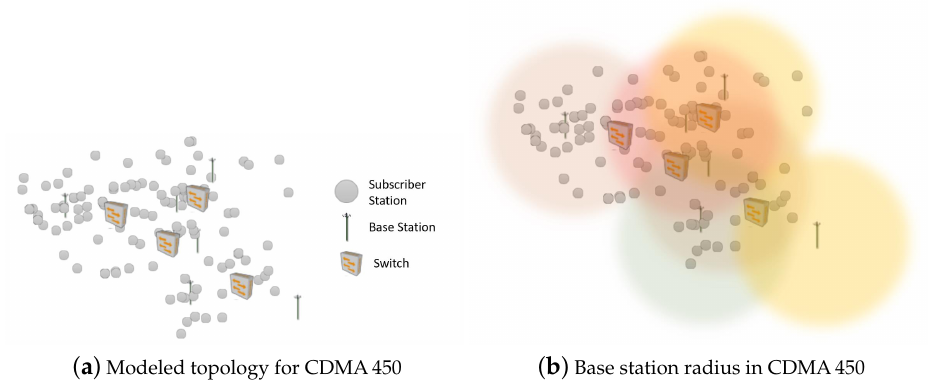
Figure 3. Topology for CDMA450 in